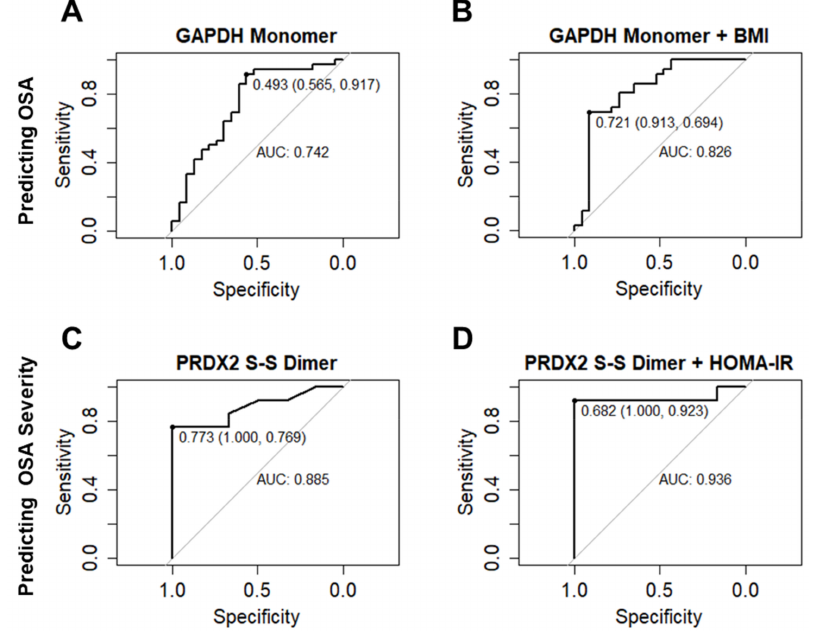
Figure 4. Receiver Operating Characteristic (ROC) curves for the models using GAPDH and PRDX2 to classify patients at risk for OSA or OSA severity. The different redox–oligomeric forms of GAPDH or PRDX2 were used as predictors in logistic regression models and Receiver Operating Characteristic (ROC) curves were used to assess their potential discriminative power in classifying patients at risk for OSA or as predictor of OSA severity. The best results to predict patients at risk for OSA were obtained for the GAPDH monomer alone (AUC: 0.742; 0.917 sensitivity; and 0.565 specificity) ( A ) or combined with Body Mass Index (BMI) parameter (AUC: 0.826; 0.694 sensitivity; and 0.913 specificity) ( B ). The best results to discriminate severe OSA from mild–moderate OSA were obtained for the PRDX2 S-S Dimer alone (AUC: 0.885; 0.769 sensitivity; and 1.000 specificity) ( C ) or combined with the homeostatic model assessment for insulin resistance (HOMA-IR) metabolic parameter (AUC: 0.936; 0.923 sensitivity; and 1.000 specificity) ( D ). The respective optimal cut-off values and the specificity and sensitivity values (within parenthesis) are displayed in the